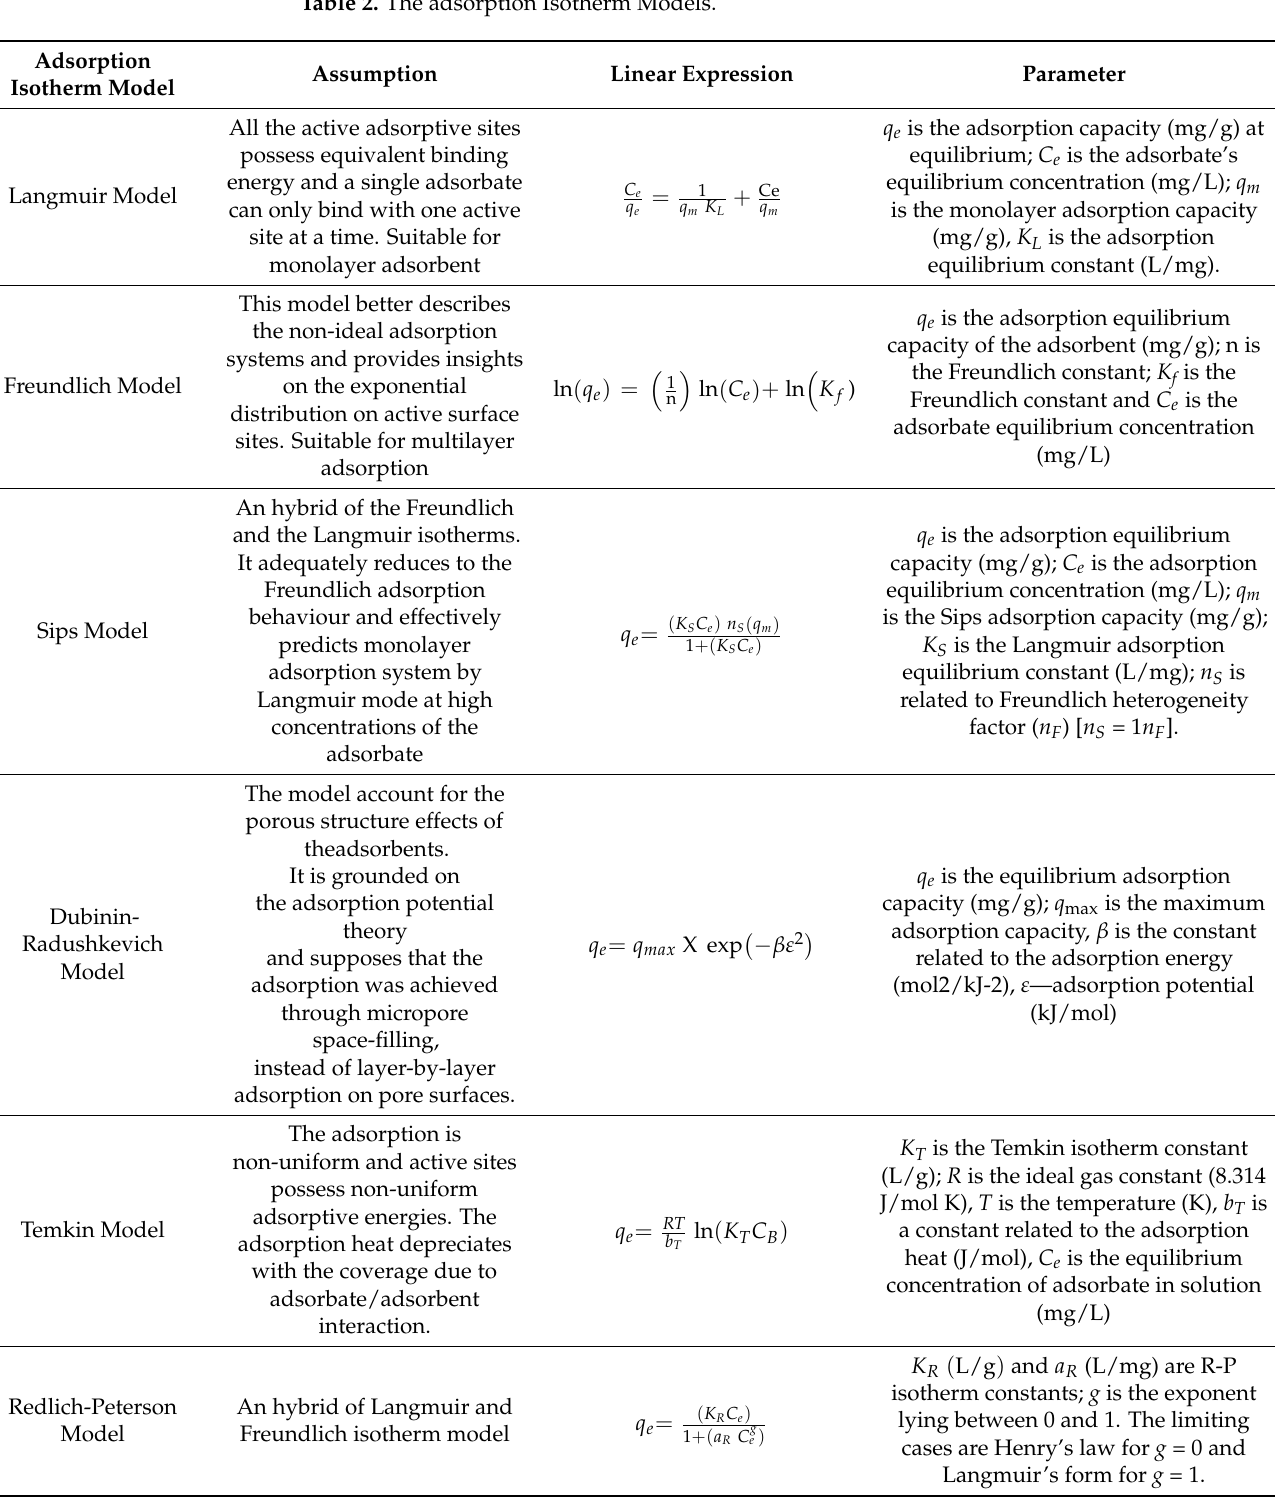
Table 2. The adsorption Isotherm